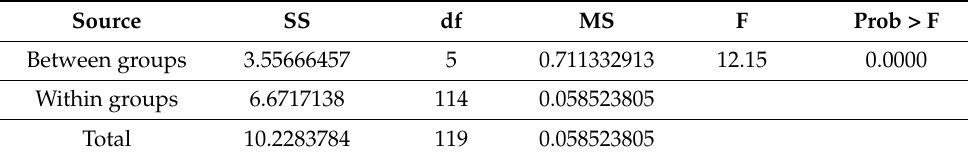
Table 3. Analysis of variance.